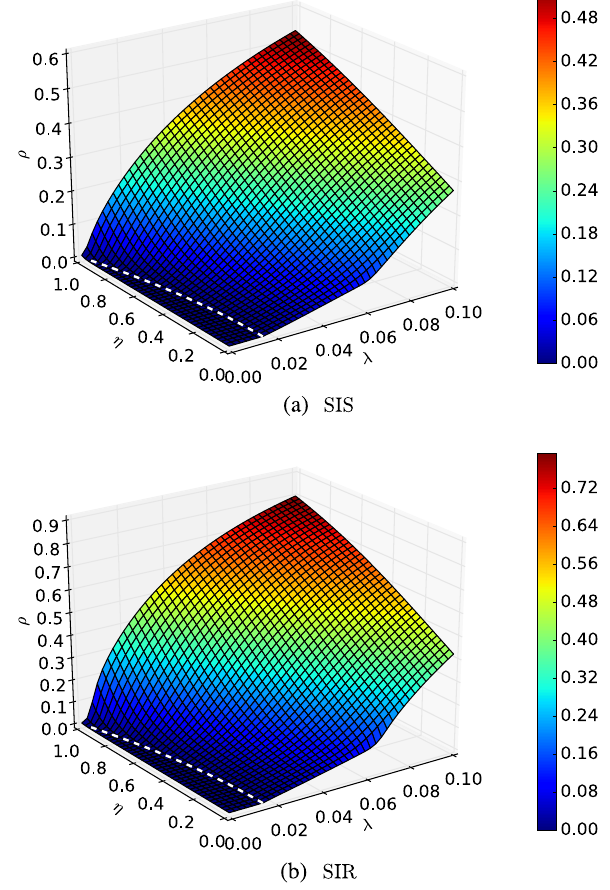
FIG. 2. Phase diagrams over a two-layer multiplex system, where each layer is a scale-free network with n ¼ 10 4 nodes, for a fixed value of μ ¼ 1 . (a) Density of spreaders as a function of the parameters η and λ . (b) Density of recovered individuals as a function of the parameters η and λ . Colors represent the fraction of spreaders, and the white line is the threshold calculated using Eq.